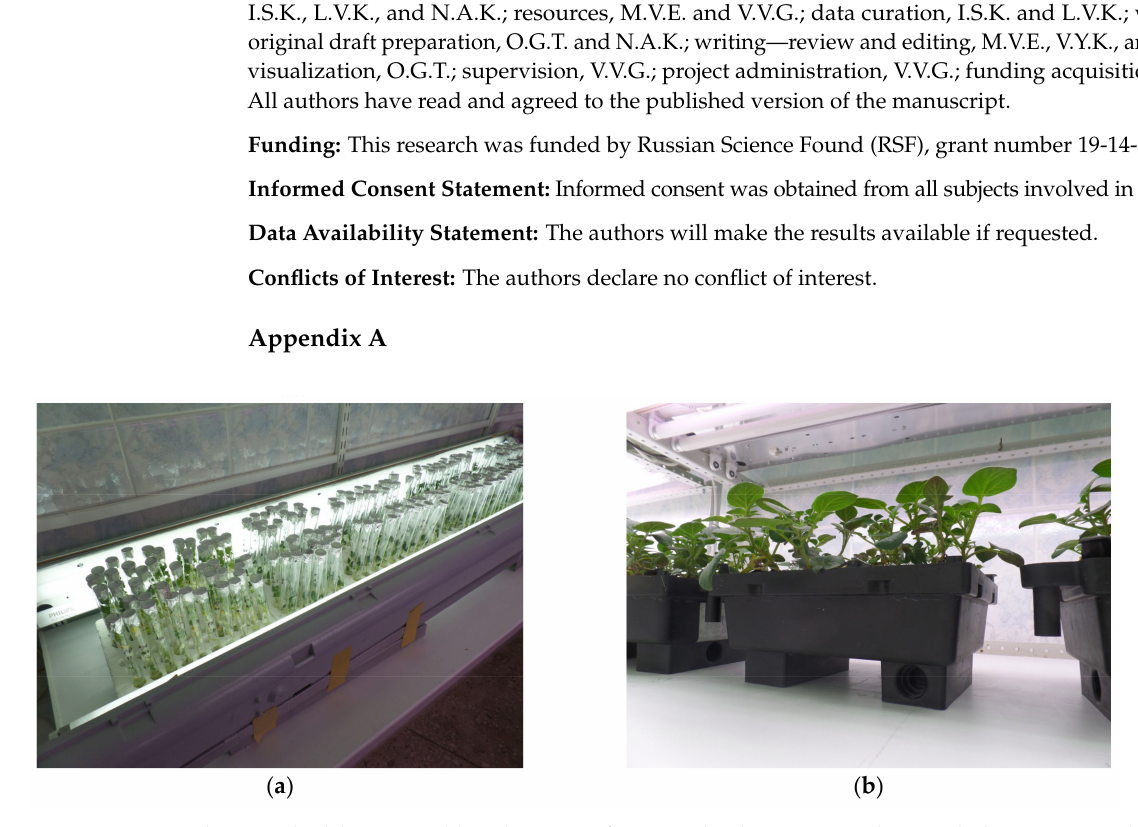
Figure A1. Growing plants in the laboratory: ( a ) Cultivation of potato plantlets on Murashige and Skoog agar medium; ( b ) Cultivation of potato seedlings in a liquid half-strength modified Murashige and Skoog agar medium (without sucrose and agar).